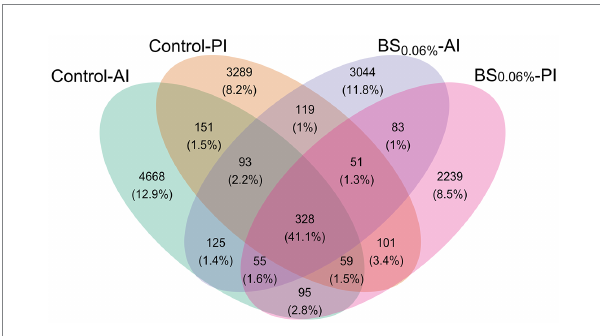
FIGURE 2 Venn diagram plotting the number and relative abundances (%) of ASVs that are unique or common among experimental groups. Experimental groups ( n = 12 fish per group): anterior (Control-AI) and posterior intestine (Control-PI) of gilthead seabream ( Sparus aurata ) fed the control diet, and anterior (BS 0.06% -AI) and posterior intestine (BS 0.06% -PI) of S. aurata fed a basal diet supplemented with a blend of bile salts at a dietary inclusion level of 0.06% (BS 0.06%